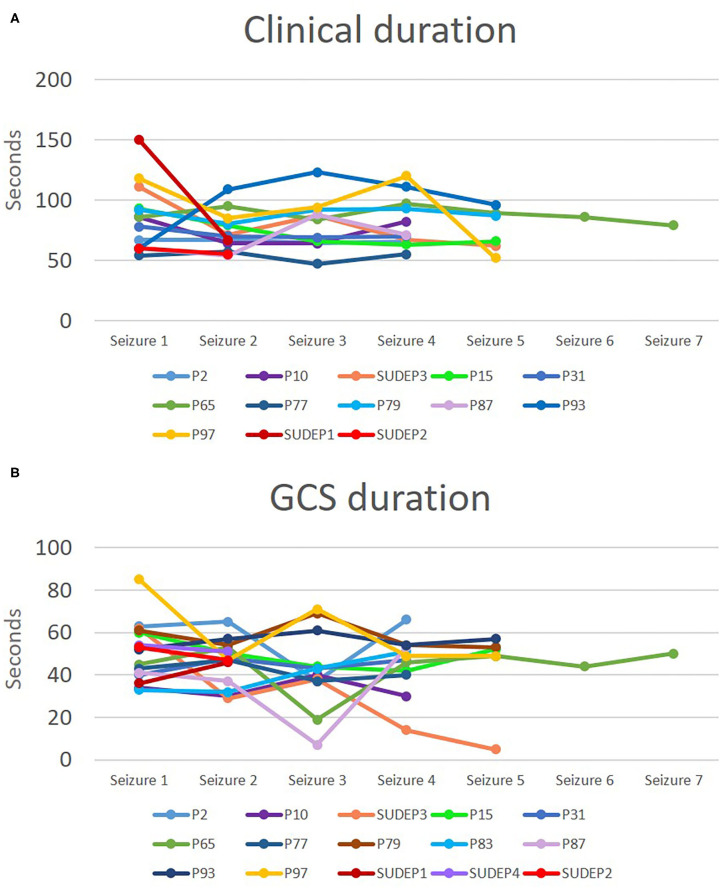
Clinical seizure and convulsive phase durations in patients with at least four seizures in a cluster and for SUDEP cases. Durations for clinical seizure (A) and for GCS (B) are depicted. Each line represents a cluster and each point represents the duration in seconds for a specific seizure in the cluster.